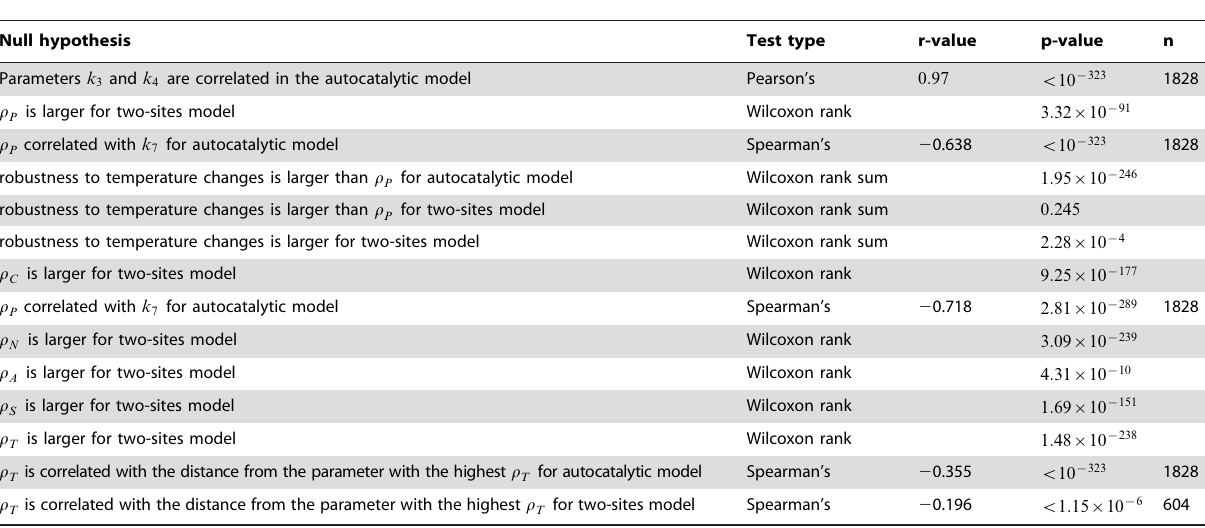
Table 1. Statistical tests and their significance used to assess model discrimination and correlations.